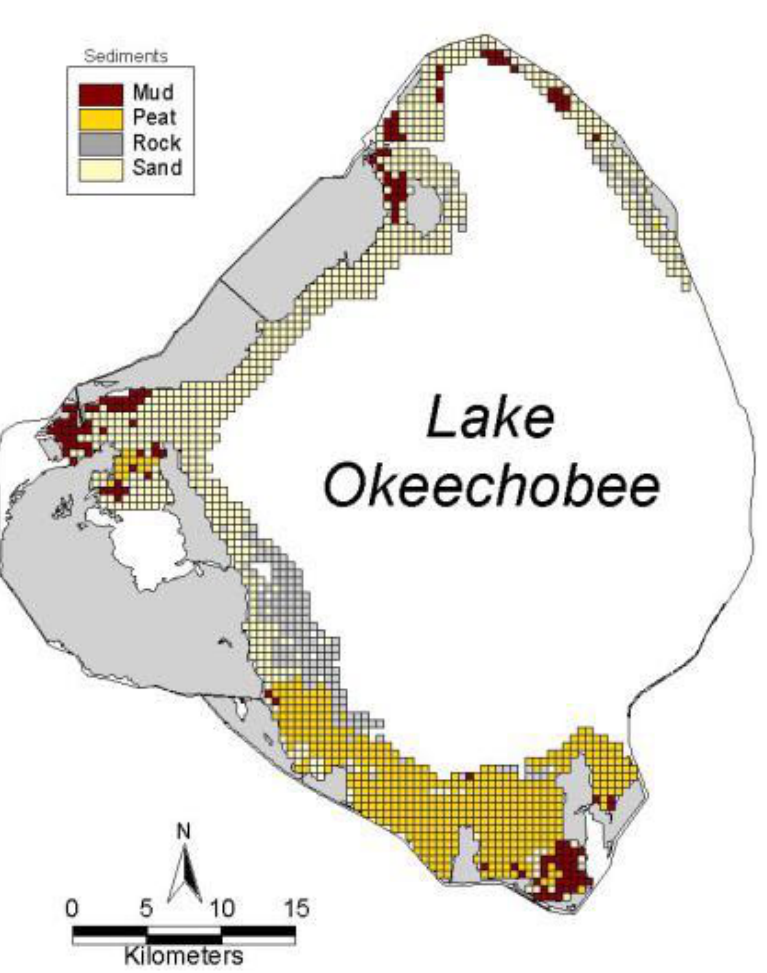
FIGURE 1. GIS maps showing (A) the distribution of mud, peat, rock, and sand sediments; (B) water column depths; and (C) Secchi depths, as a percent of water column depth; in the near-shore region of Lake Okeechobee where submerged aquatic vegetation occurred in late summer 2000. Each square is 500 x 500 m. The light gray shaded area along the western shoreline is the lake‘s littoral zone of emergent vegetation. The white area is deeper water that was not